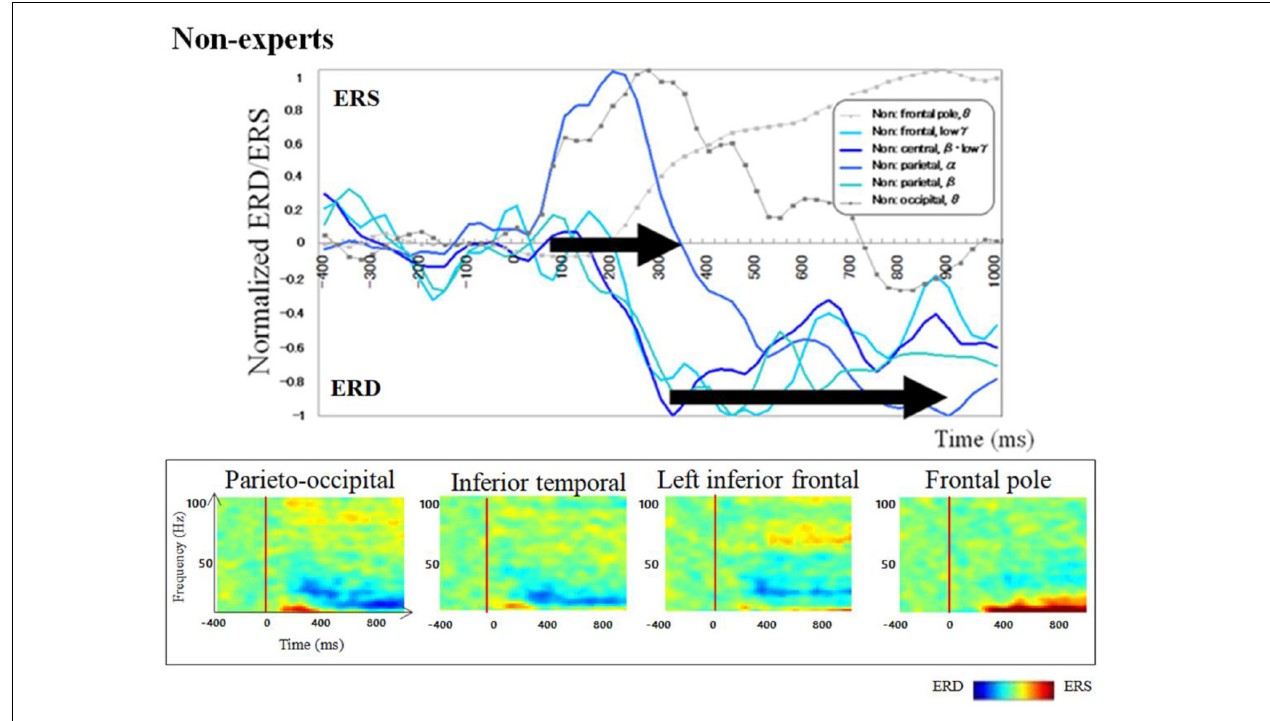
FIGURE 7 | A group average of a time-frequency profile of oscillatory changes for non-experts during mental addition experiments. The upper graph shows the time course of the normalized oscillatory changes in the frequency bands specific to the detected areas and lower graphs show time-frequency spectrograms in each area. The time window is between − 400 and 1,000 ms; the movement onset is at 0 ms, and the frequency interval ranges from 4 Hz to 100 Hz. The red areas in the time-frequency maps indicate increases in power (ERS), and the blue areas indicate decreases in power (ERD). In the figure legend, “Non.” means non-abacus